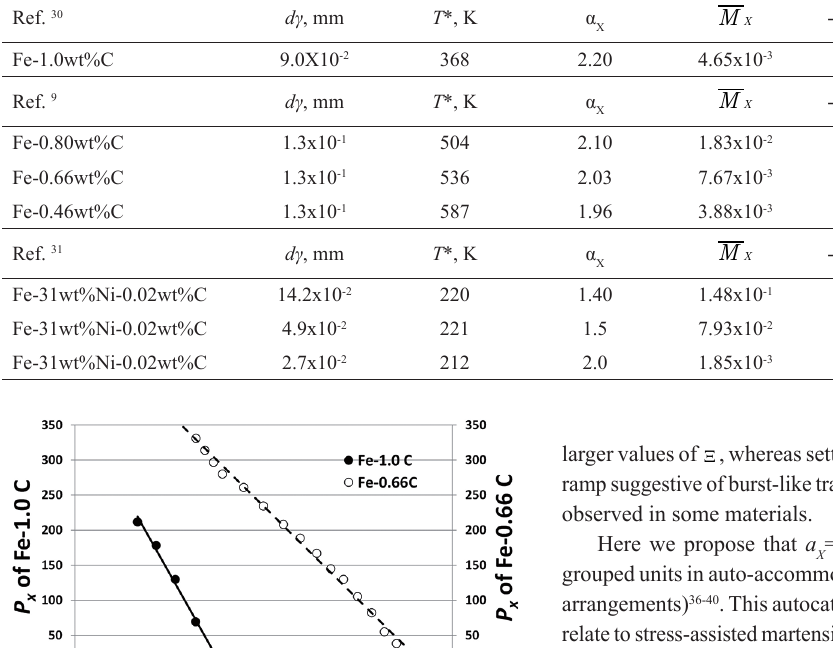
The reference chart in Figure 7, represented by filled carats,